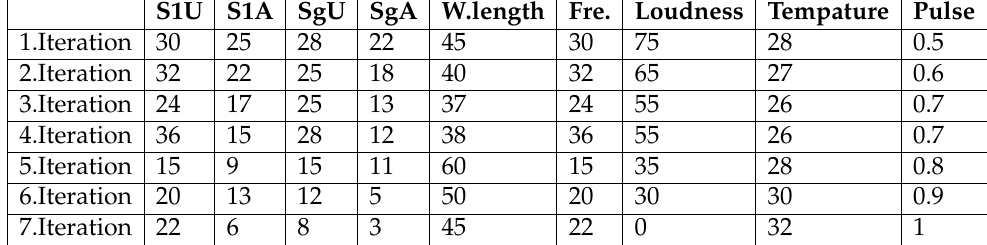
Table 2. Execution of Algorithm 2 with Test